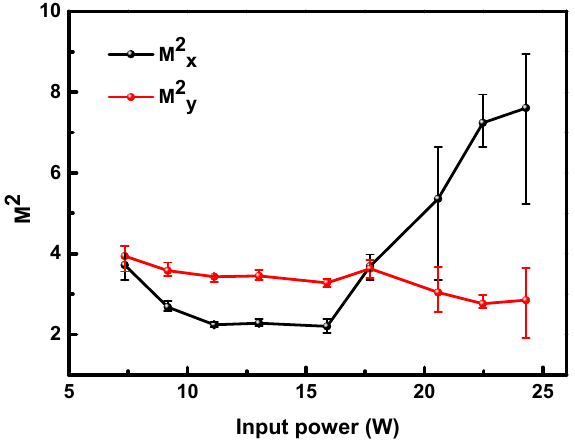
Figure 8. Beam quality M 2 factors of the green laser in x and y directions.